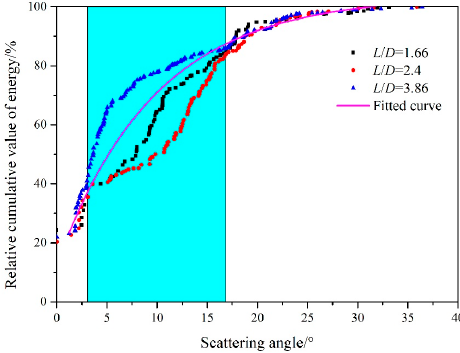
Figure 15. Relative cumulative energy distribution of BAD.